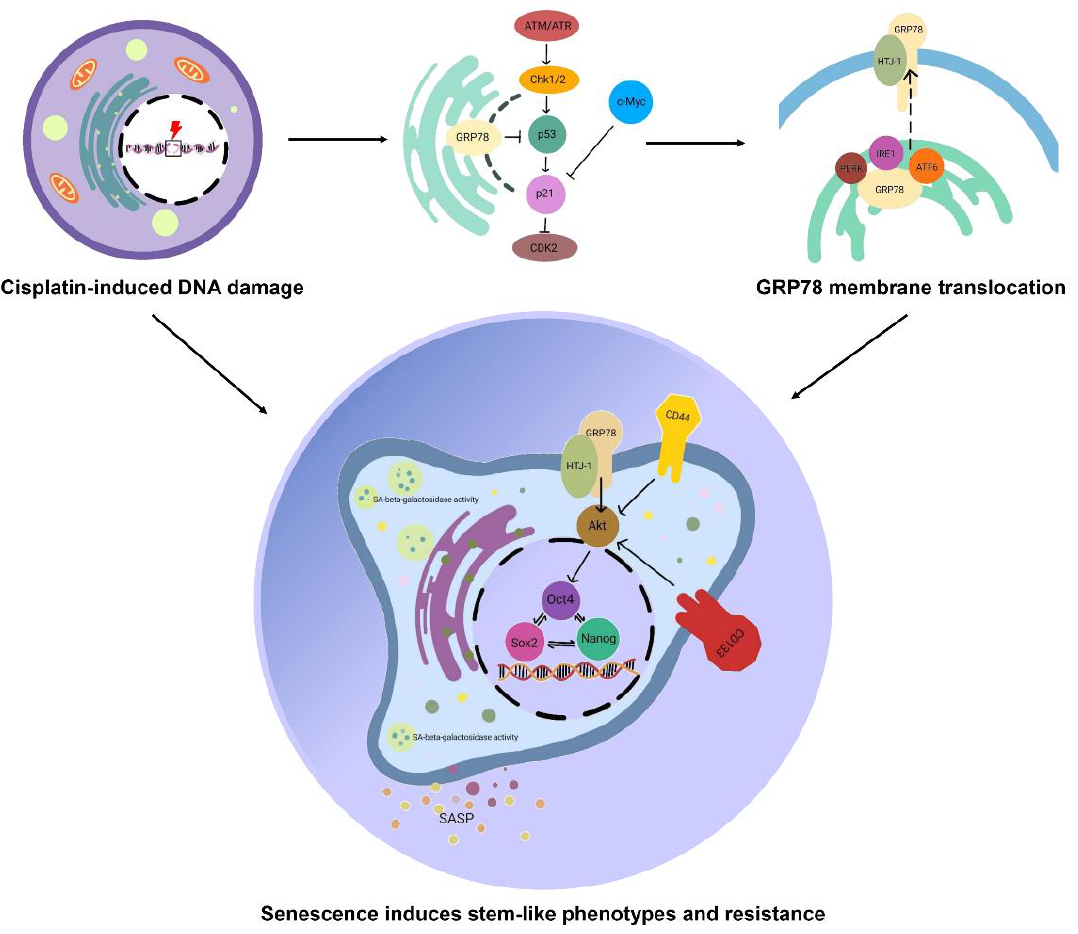
Figure 5. In normal conditions, GRP78 is mainly located in the ER or mitochondria and controls ER homeostasis. It balances the survival of the cells by regulating cell cycle progression through the inhibition of cyclin-dependent kinase inhibitors such as p21. GRP78 interacts with PERK, IRE1, and ATR6 in an unstressed environment and dislocates from these UPR sensors during cellular stress. Cisplatin induces cellular senescence via the DNA damage mechanism via p53 and p21 activation. According to stress stimuli, GRP78 shifts from ER residence to the cell surface membrane, where it is anchored with MTJ1/HTJ1. Signal transduction from cell surface GRP78 can trigger the Akt signaling pathway, resulting in the upregulation of self-renewal transcription factors, Nanog, Oct4, and Sox2. Moreover, the cells which undergo cellular senescence demonstrate higher expression of stemness markers CD133 and CD44.